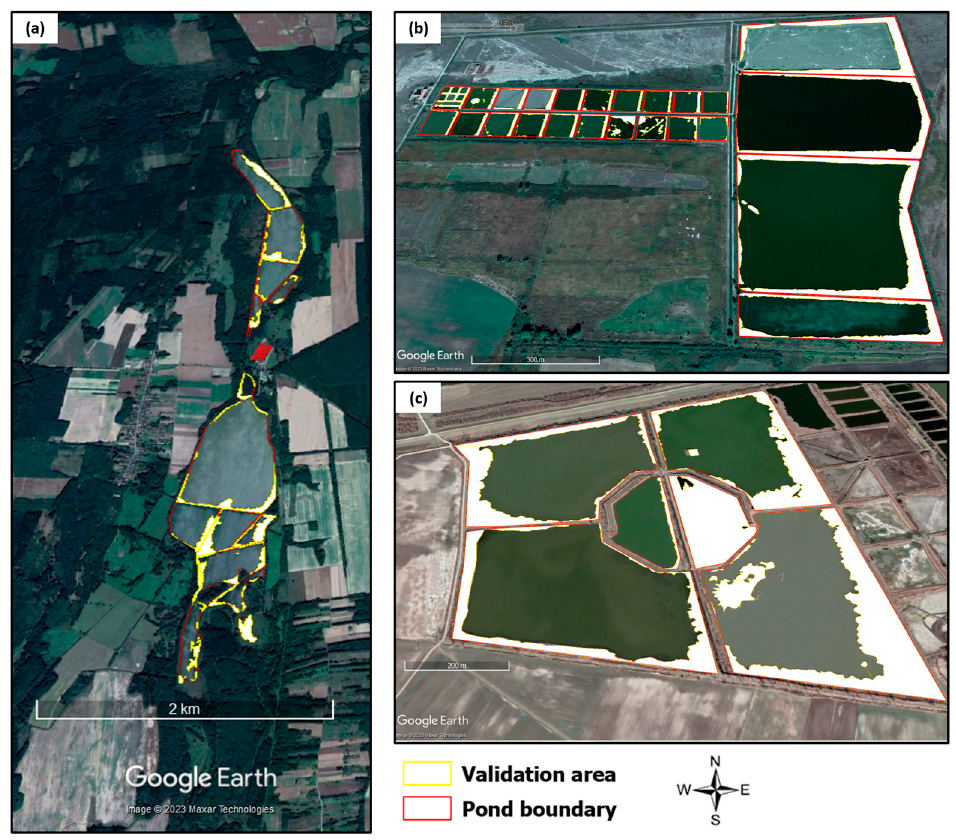
Figure 5. Example illustrating the use of high-resolution Google Earth Pro imagery to create the validation sets for the fish ponds in ( a ) STD for the year 2018, ( b ) the NGP for the year 2020, and ( c ) the SGP for the year 2019.